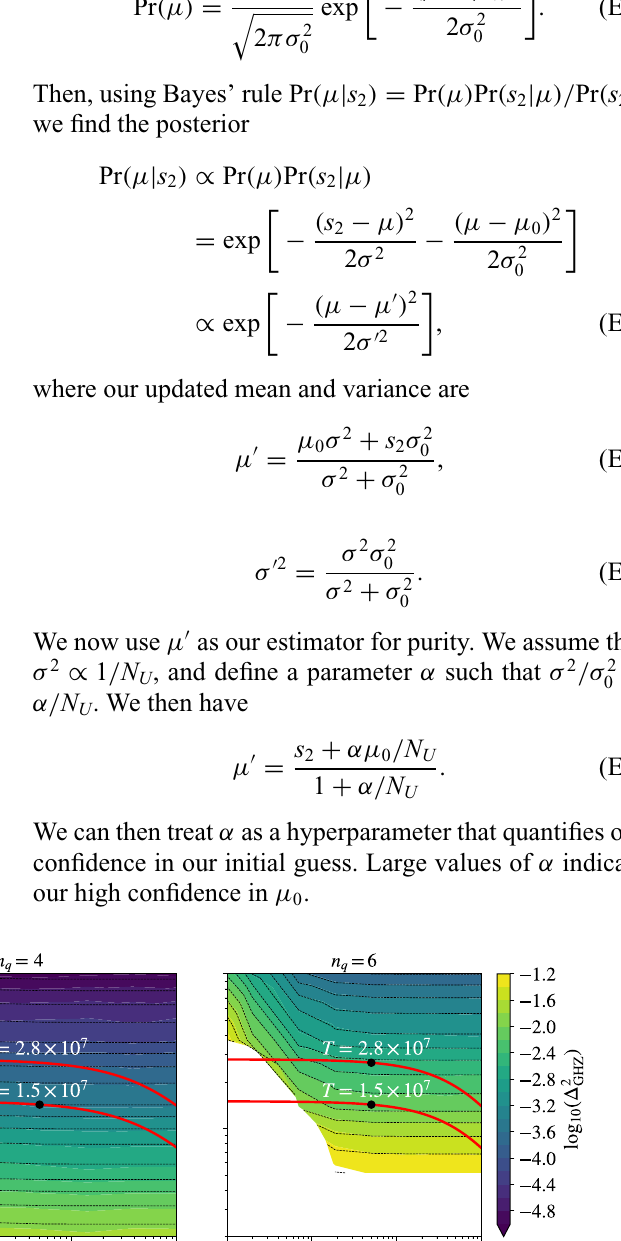
. The dashed lines indicate the contours obtained from the empirical fit GHZ ( 1000 + N ) for T = 1.5 × 10 7 and T = 2.8 × 10 7 , U S > 0.1. We observe that, in this GHZ